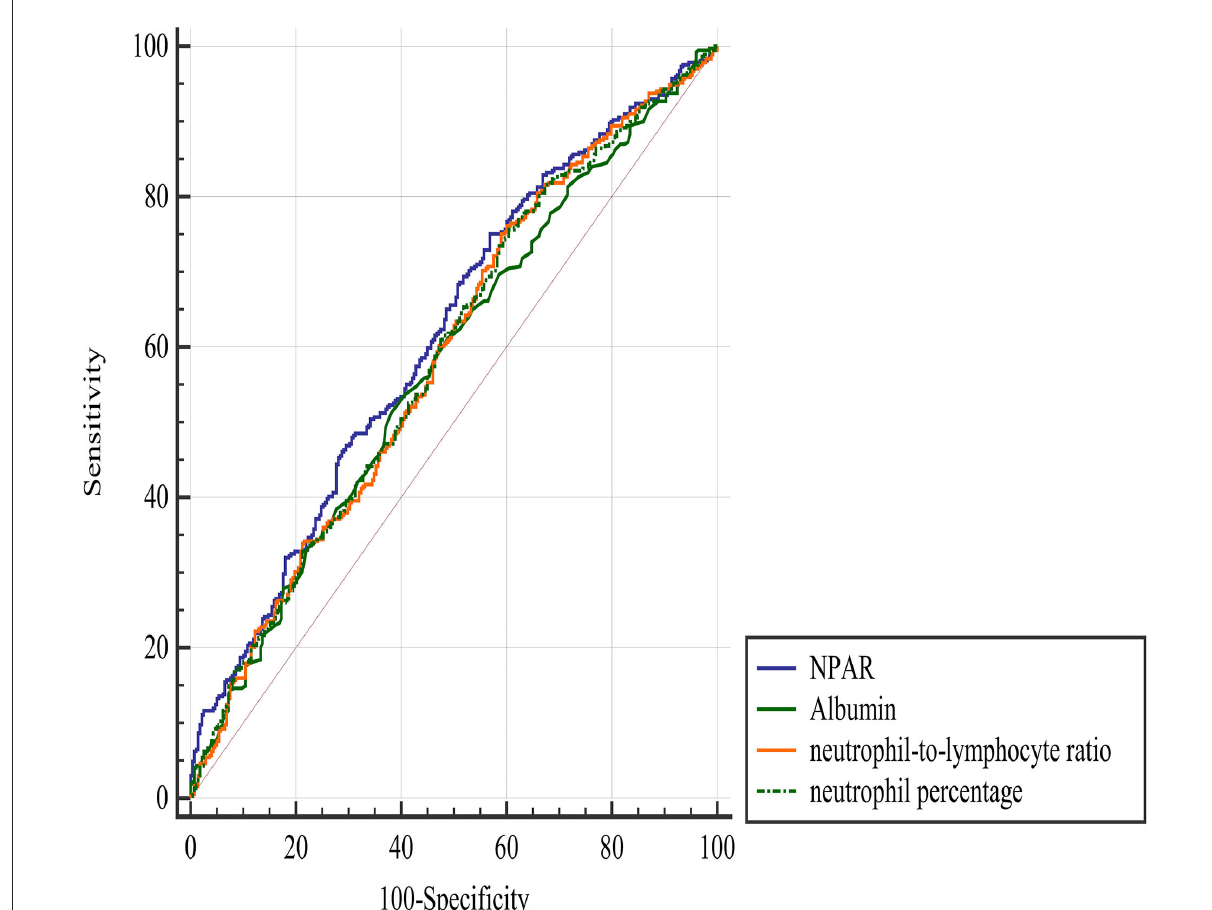
FIGURE2 Comparison of predictive value between NPAR and other parameters in the prediction of a 3-month poor functional outcome. NPAR, neutrophil percentage-to-albumin